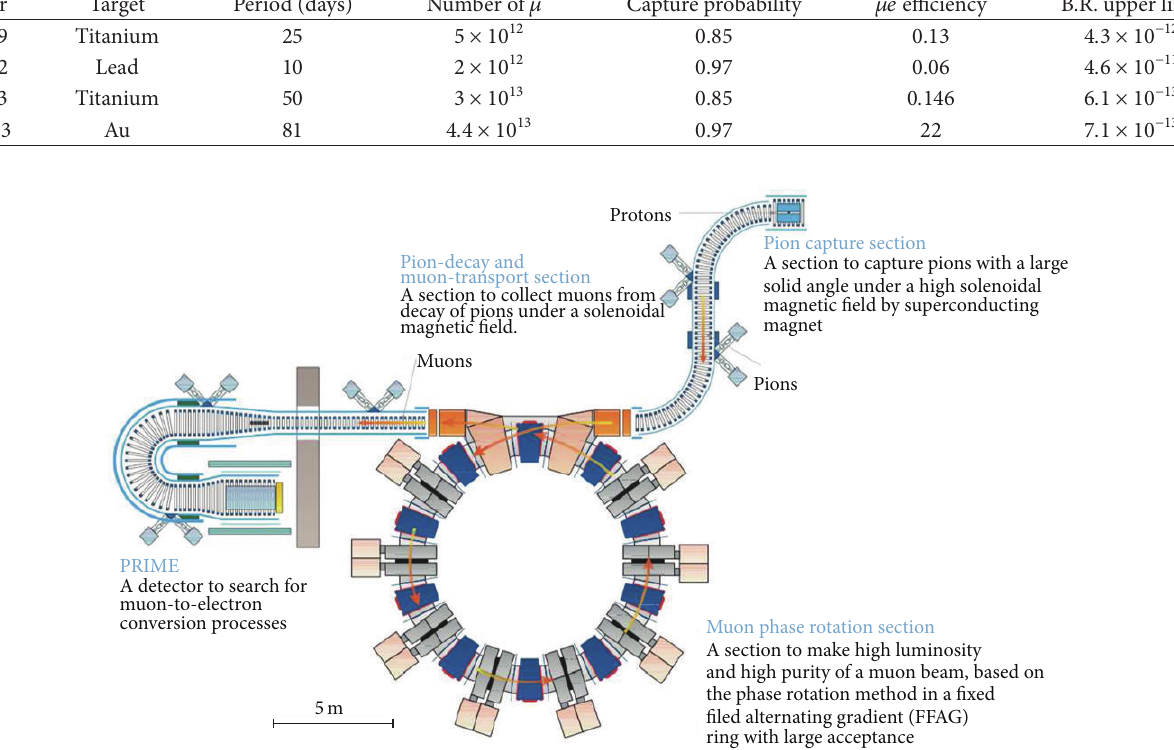
Figure 27: Layout of the PRISM/PRIME